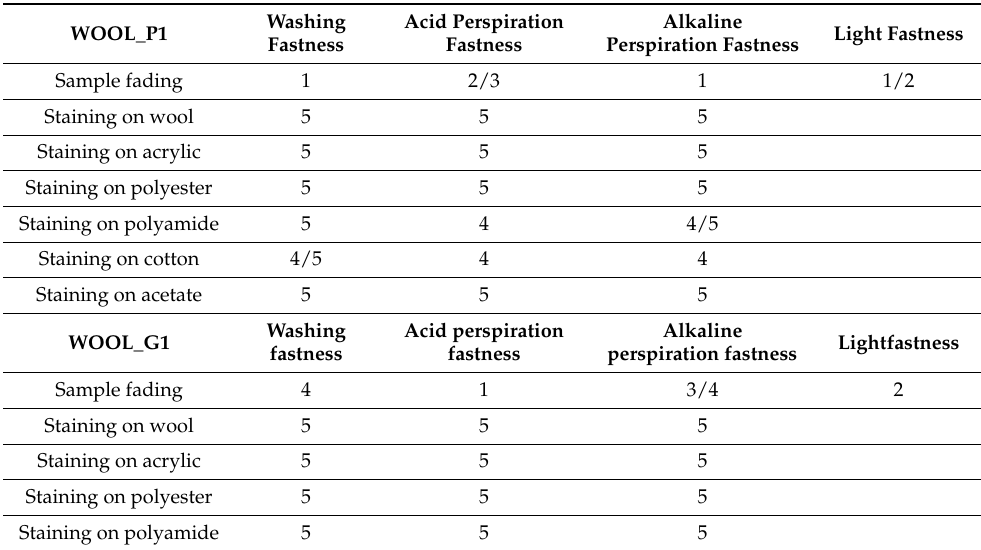
Figure 13. The visual appearance of dyed wool yarn samples before and after washing with a mildly alkaline reference detergent. ( a ) WoolP_1 before washing. ( b ) WoolG_1 after washing. ( c ) WoolP_2 before washing. ( d ) WoolG_2 after washing. Table 4. Fastness analysis of dyed wool yarn samples before and after washing with a mildly alkaline reference